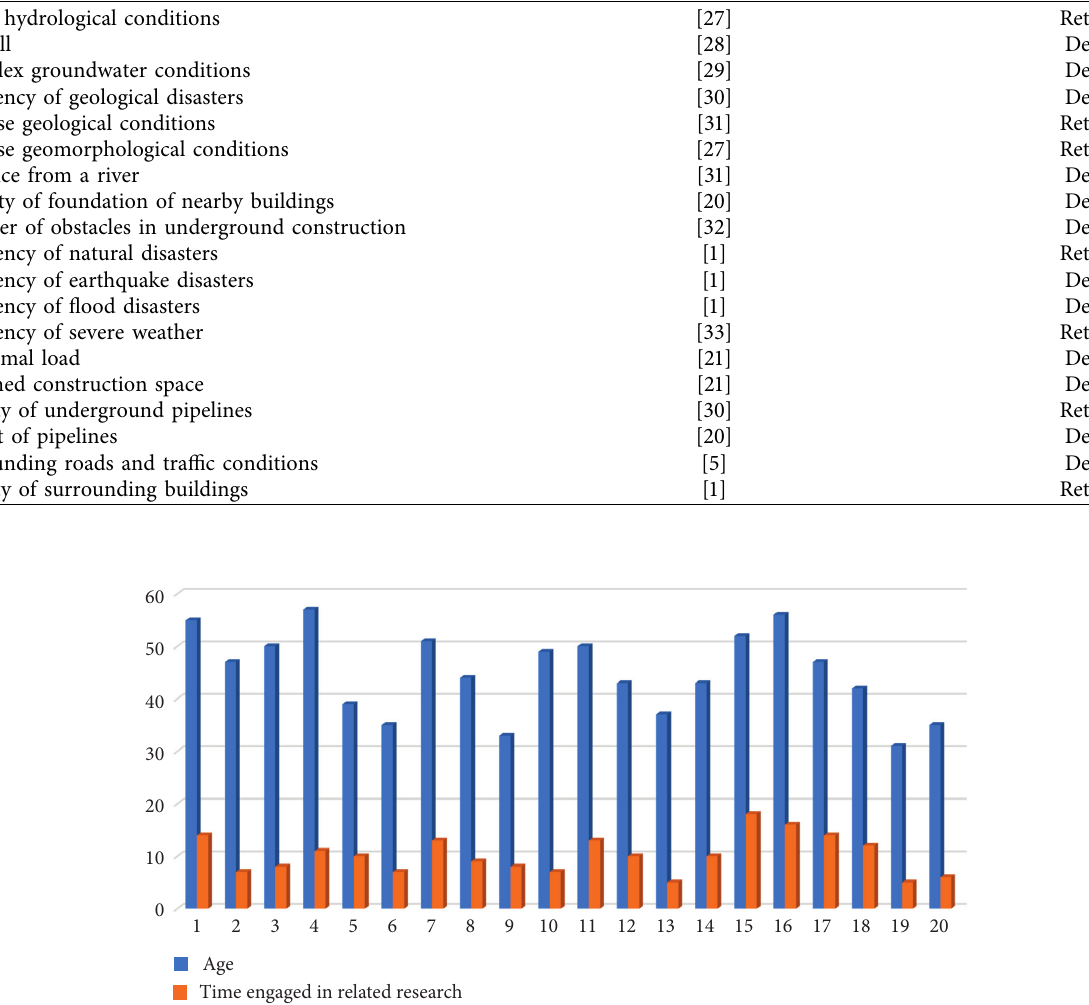
Figure 1: Distribution of age and working years of review experts participating in this project.